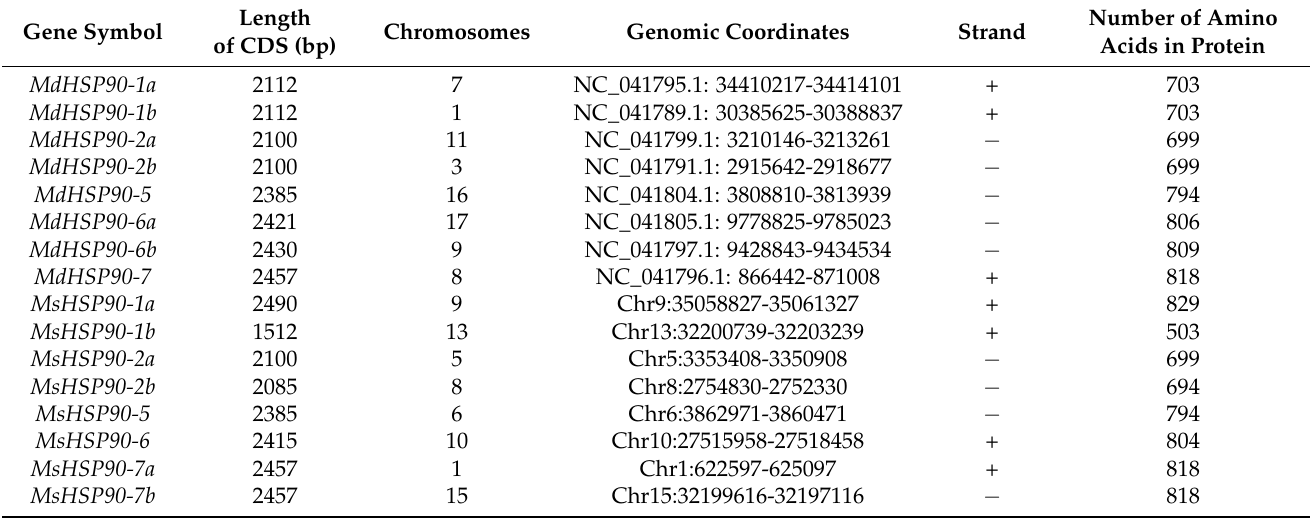
Table 1. HSP90 genes in M. domestica and M. sieversii .